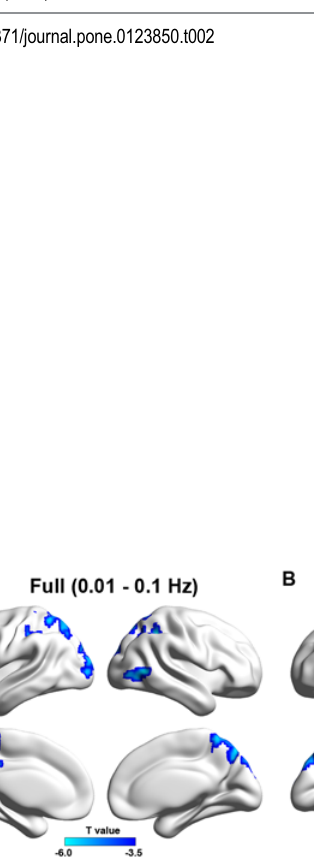
Fig 1. ALFF differences in three different frequency bands (A, typical band: 0.01 – 0.1 Hz; B, slow-5: 0.01 – 0.027 Hz; C, slow-4: 0.027 – 0.73 Hz) between stroke patients and healthy controls. Cold colors indicate regions showing lower ALFF in patients versus the controls. Threshold for ALFF: p < 0.05 (corrected). Left in the figure shows the left side of the